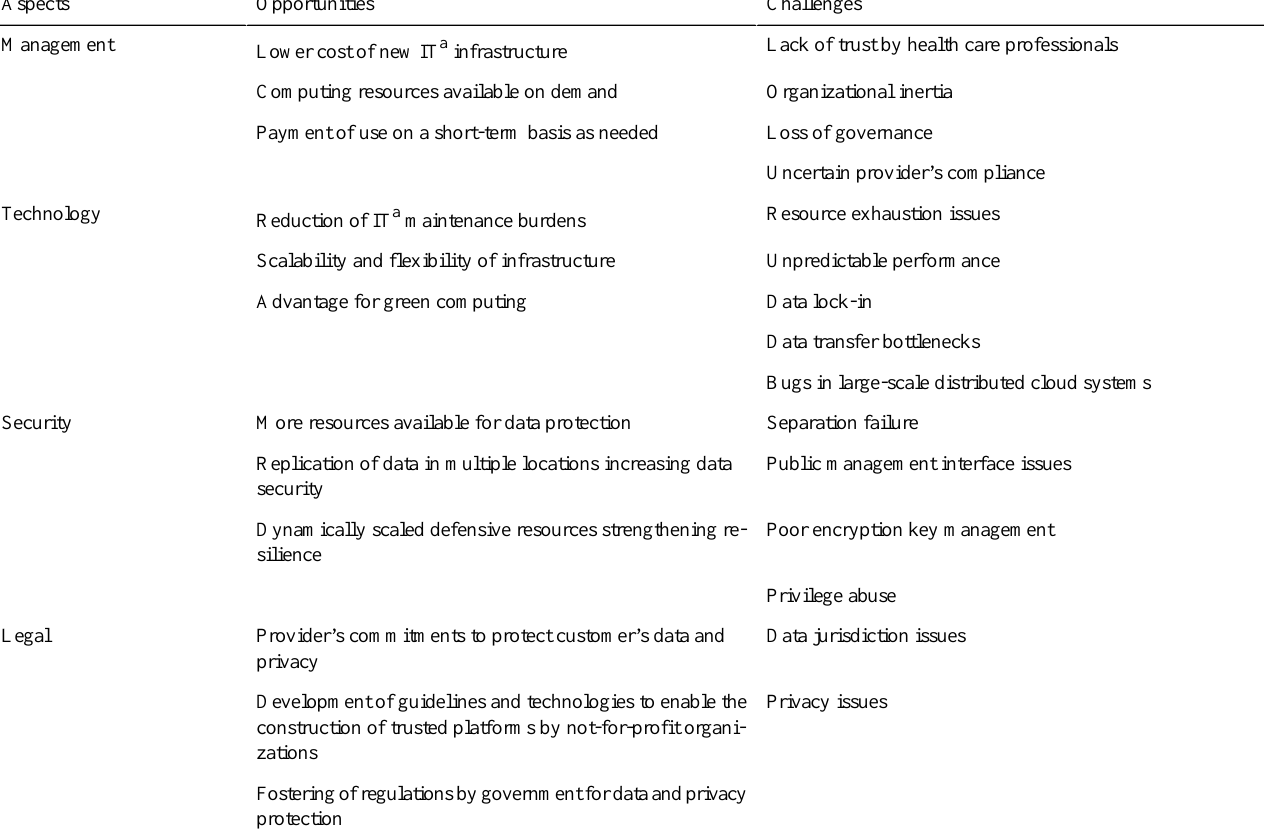
Table 1. Cloud computing opportunity and challenge summary